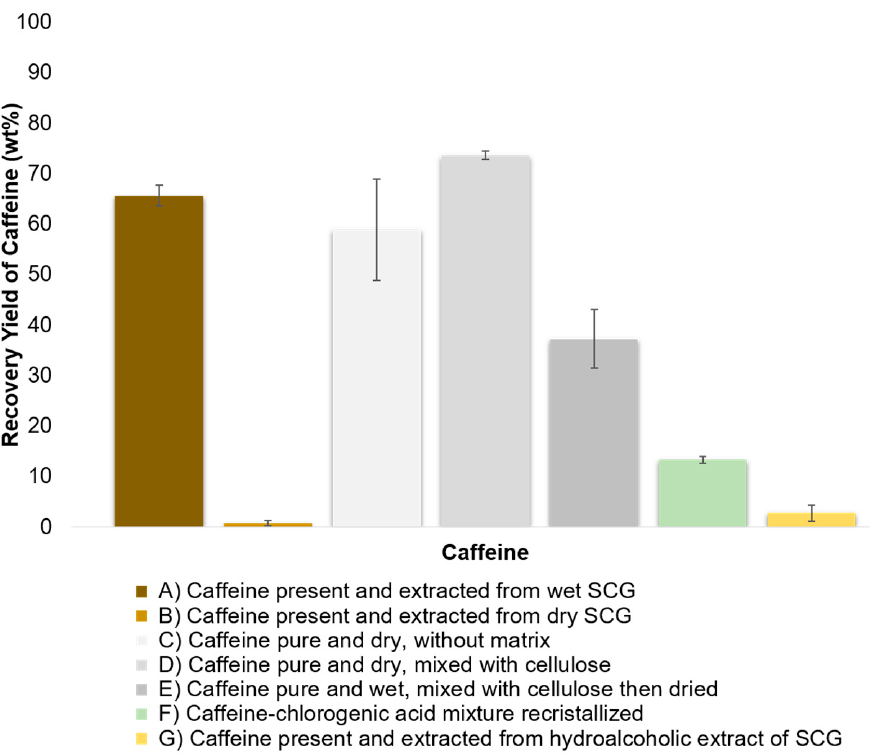
Figure 4. Recovery yield of caffeine extracted from different matrices by supercritical CO 2 extractions. The experiments (A) and (B) expose the large influence of water for the caffeine extraction from